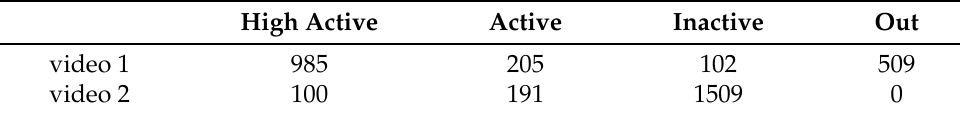
Table 3. Duration of activity levels in seconds for video 1 and video 2.